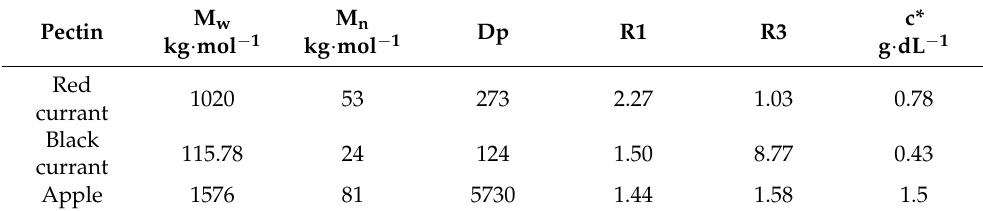
Table 1. Molar masses and chain properties of pectin from different sources